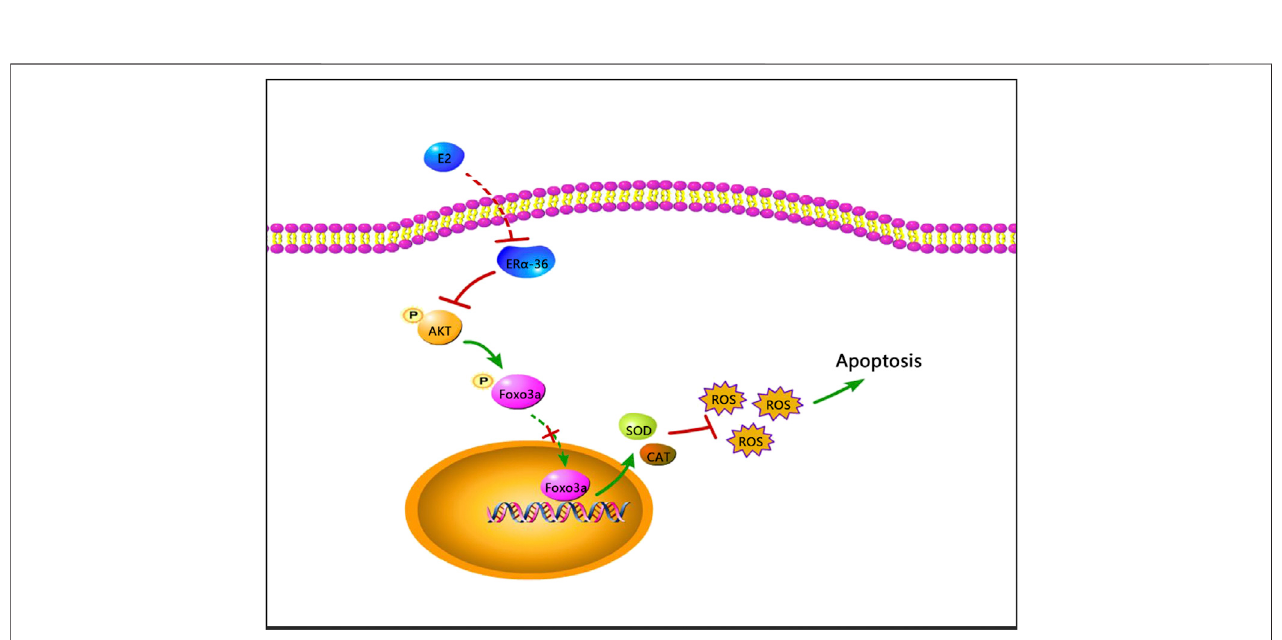
FIGURE 8 | A schematic of a possible mechanism whereby apoptosis may be induced by 17 β -estradiol in HepG2 cells.